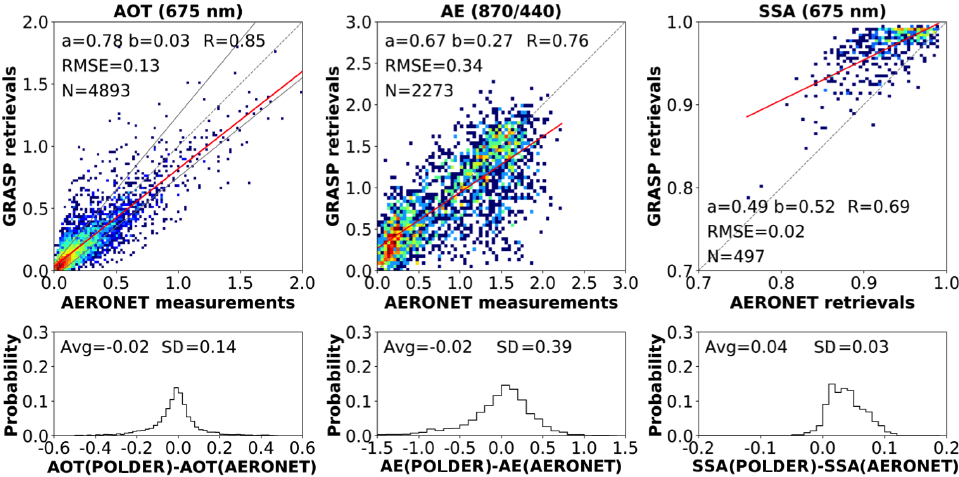
Figure 12. Intercomparison of aerosol optical properties retrieved using the POLDER/PARASOL component (MG mixing model) approach and the corresponding operational AERONET products from all globally available sites in 2008. Table 4. The statistics of aerosol parameters in Fig. 10: number of measurements ( N ), slope ( A ), intercept ( B ), correlation coefficient ( R ), root-mean-square error (RMSE), mean absolute error (MAE), and standard error deviation (SD). The abbreviations used in the table are as follows: GRASP approach – GA, Maxwell Garnett mixing model – MG, volume-weighted mixing model – VW; standard GRASP/PARASOL retrievals without aerosol component mixing model